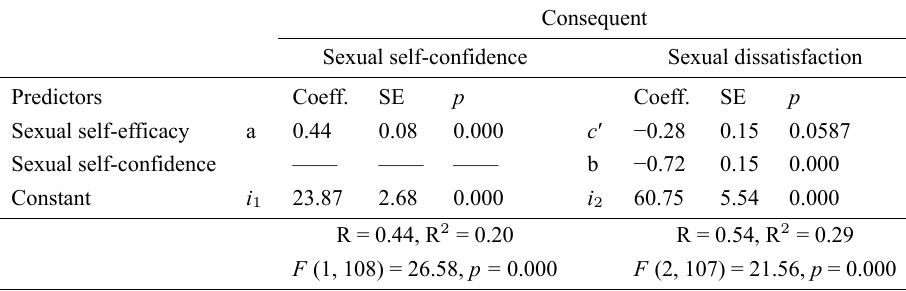
Table 3. Mediational model coefficients.